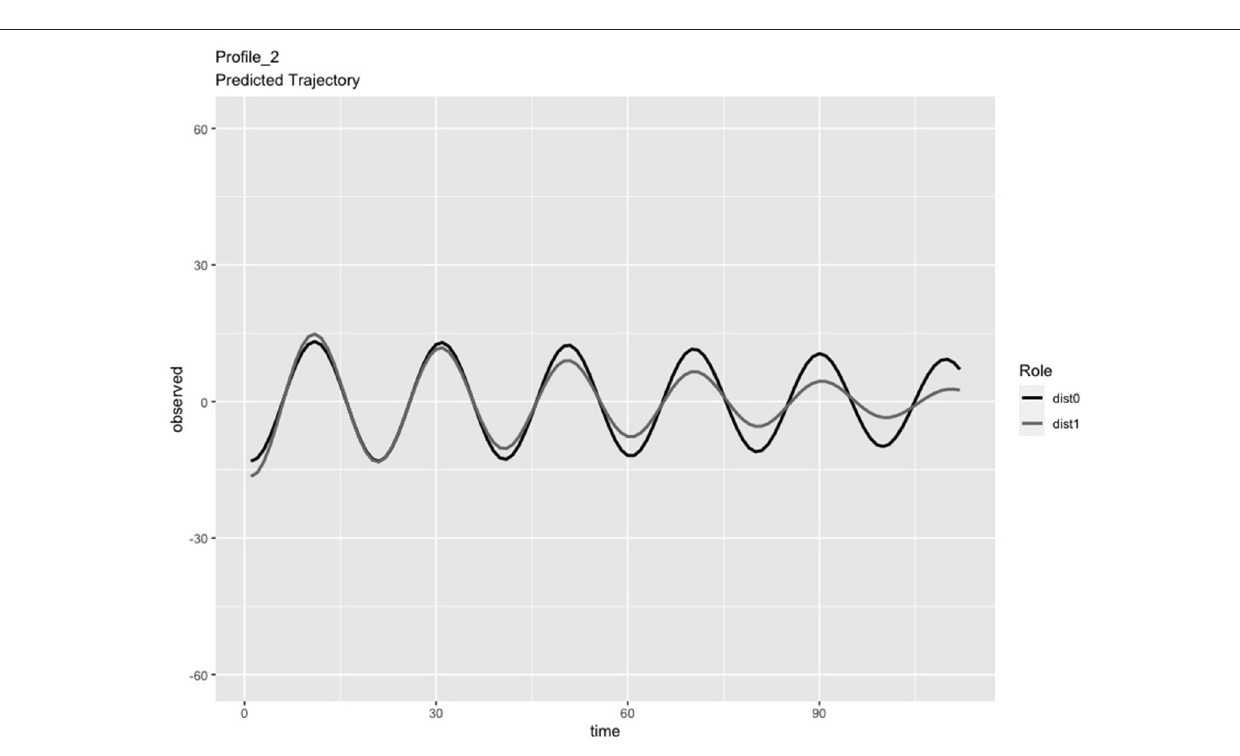
Frontiers in Neuroergonomics | www.frontiersin.org 9 February 2022 | Volume 2 | Article